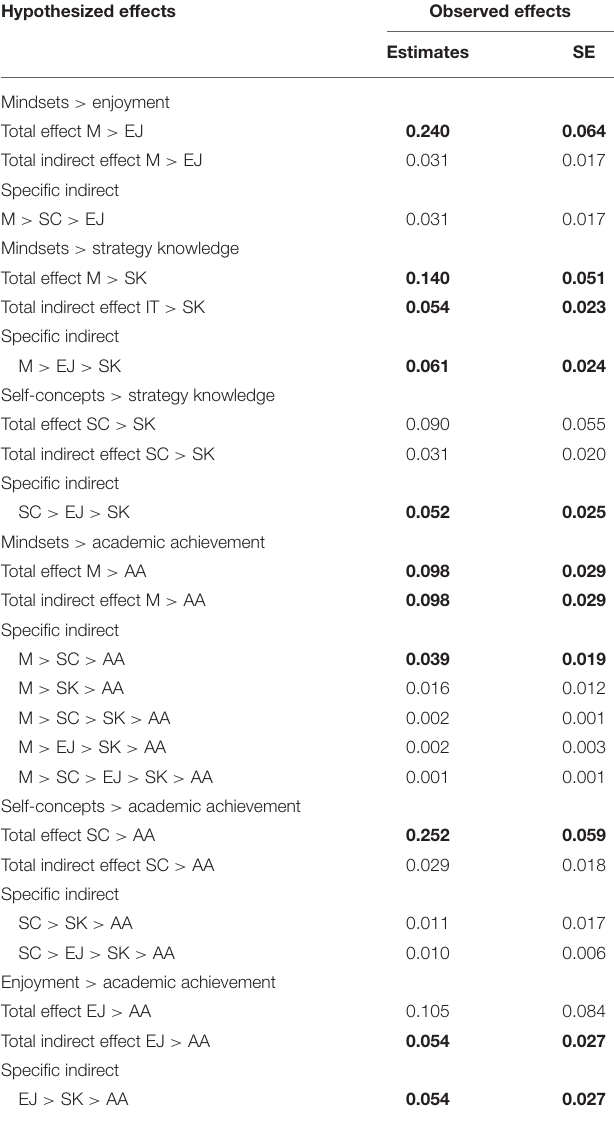
TABLE 2 | Total effect, total indirect effects and specific indirect effect of mindsets about SRL, self-concept about SRL, enjoyment, strategy knowledge, and academic